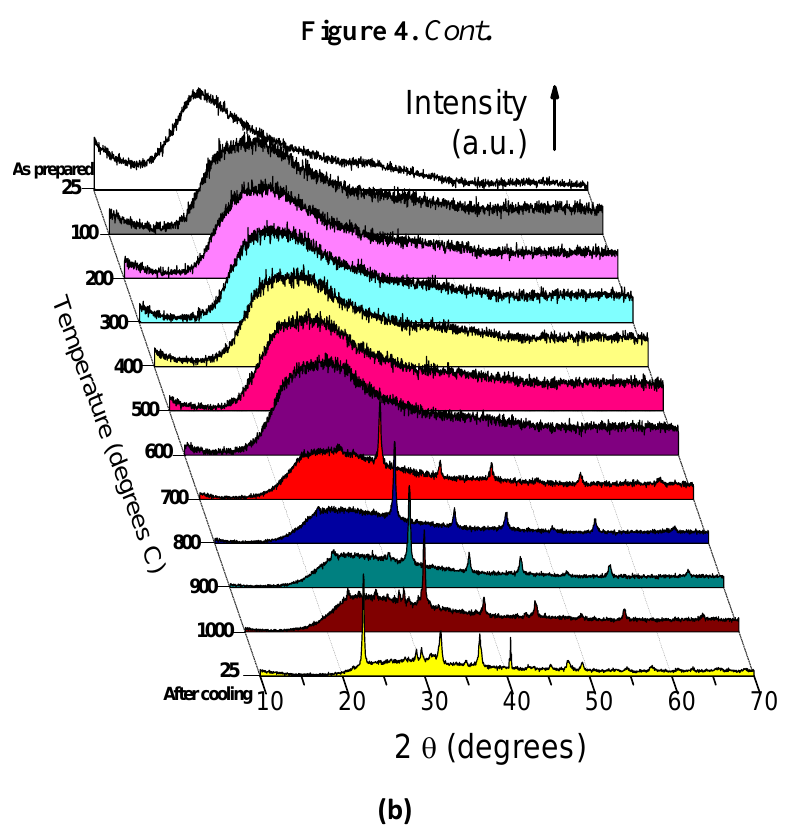
:Eu 3+ film calcined at 500 °C (a), 700 °C (b) and powder 3